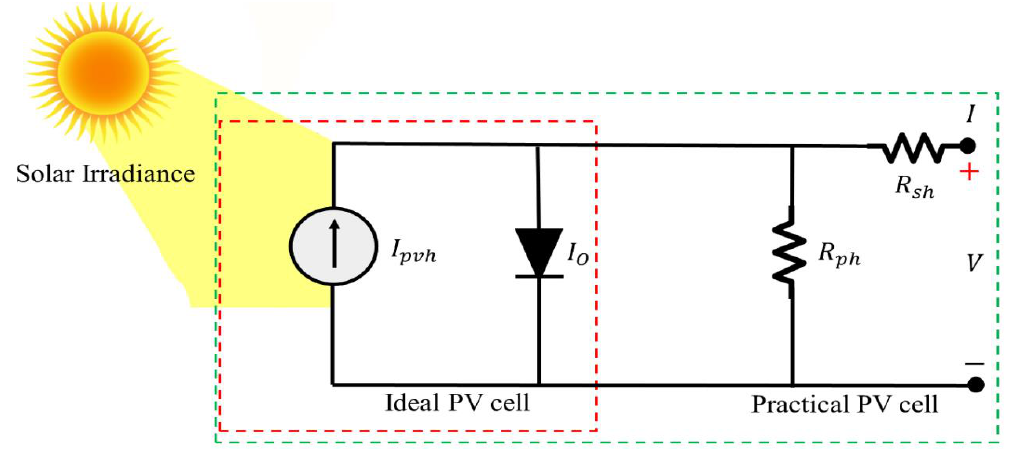
Figure 2. Single diode model of a PV cell.